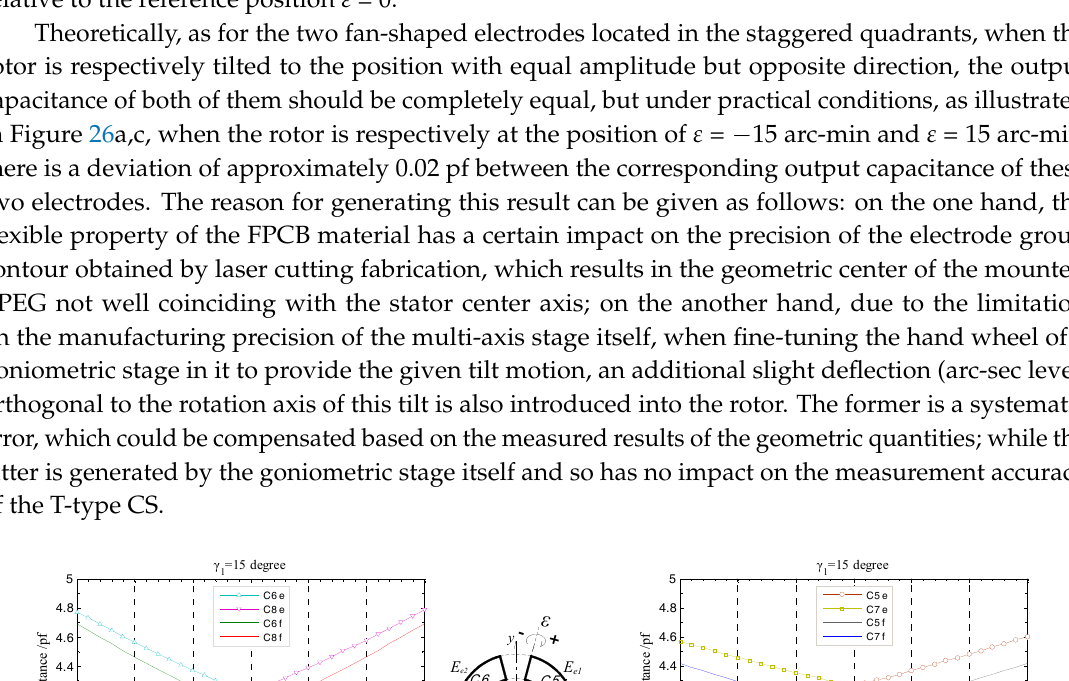
Figure 27. Comparison of experimental and simulation values of the end part differential output capacitance.